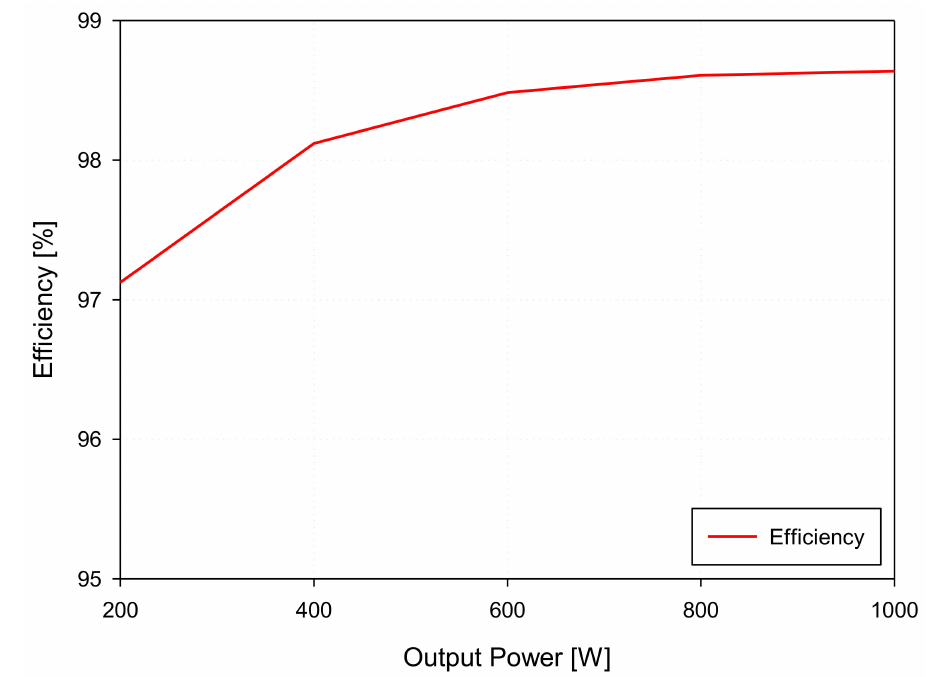
Figure 12. Efficiency characteristics by output